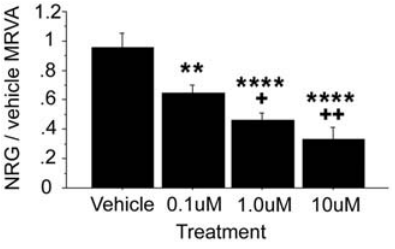
Figure 3. The selective erbB2 antagonist AG825 dampens the NRG1 a - induced MRVA. Administration of AG825 in DMSO vehicle (n=5) caused a robust, dose-dependent decrease in the MRVA induced by NRG1 a . Compared with the vehicle control, ** represents p , 0.01 and **** represents p , 0.0001. Compared with the low dose, + represents p , 0.05 and +++ represents p , 0.001.